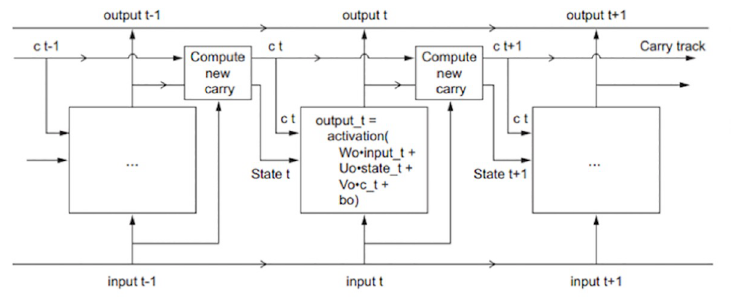
Fig 7. LSTM model